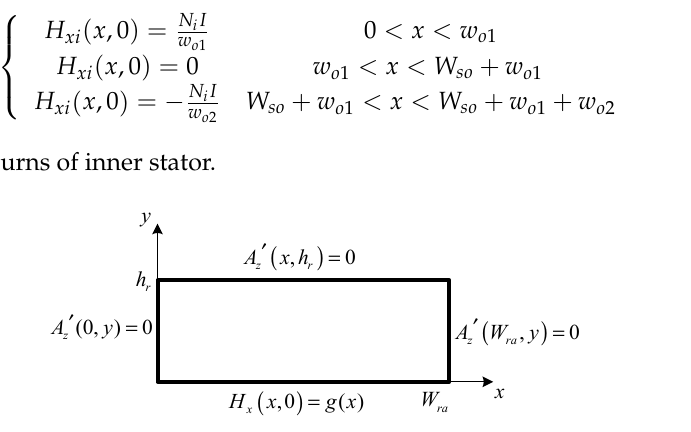
Figure 12. Boundary condition of the magnetic field intensity of the inner stator. Energies 2017 , 10 , 1603